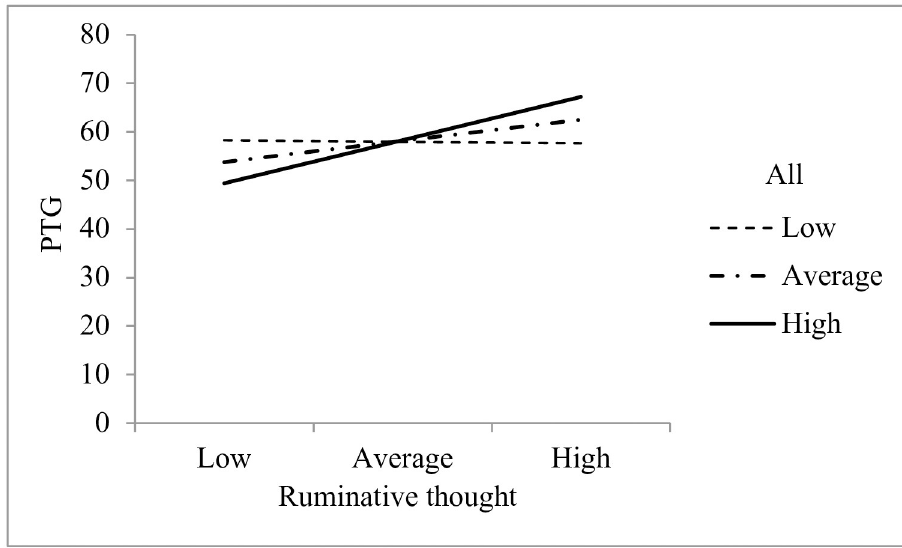
Fig 5. Simple slopes of ruminative thought predicting PTG as a function of fusion with all mothers.